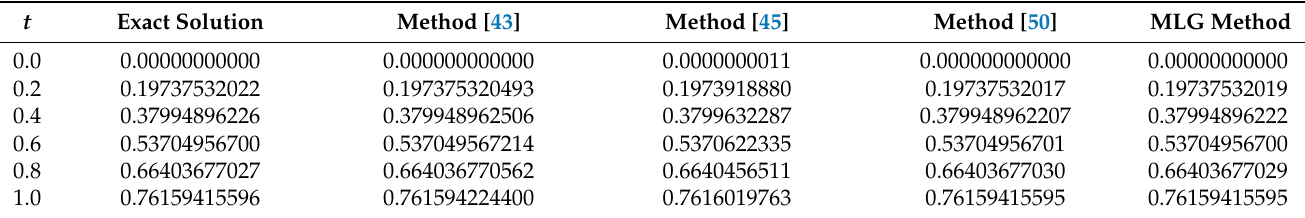
Table 2. Comparison of the approximate solutions of x ( t ) with the MLG method to the methods in [43,45,50] schemes, with ν = 1 for Example